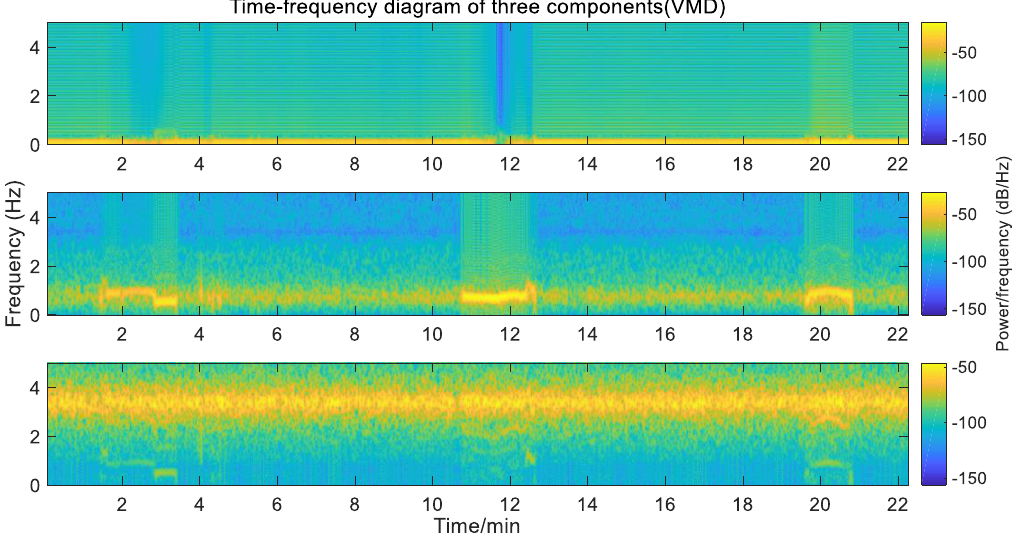
Figure 12. Time-frequency diagram of three components (GNSS displacement time series).